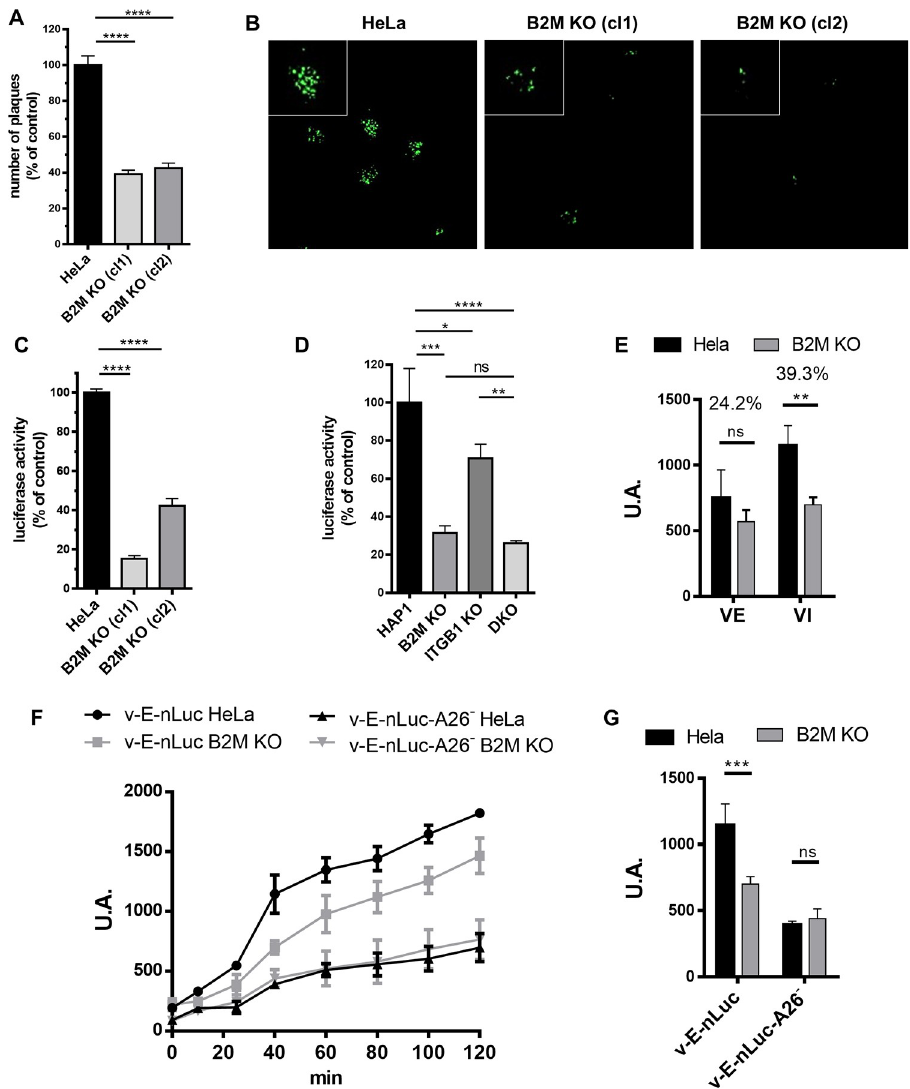
Fig 6. Effect of B2M inactivation on the early steps of Vaccinia virus infection. A) MW6 well plaques with HeLa and B2M KO clones 1 and 2 were infected with 200 pfu/well of V-GFP. Plaques were counted at 24 h.p.i B) Images of representative plaques under the microscope by GFP fluorescence. C) and D) Early luciferase expression was taken as a measure of virus entry. HeLa (C) and HAP1 (D) cells were infected with V-e.Luc at m.o.i. = 0.8 and luciferase activity was measured 3 h.p.i. Error bars indicate SD of three independent experiments. E) Infection of B2M deficient cells with extracellular virus (EV) and intracellular virus (IV). F) Time course expression of A26-defficient VV in B2M KO cells. nLuc expression was measured in triplicates in the culture medium of cells infected with the indicated viruses. G) Effect of A26 deletion on virus entry. nLuc activity at 40 min after virus adsorption is shown. p-values: ���� < 0.0001, ��� < 0.001, �� < 0.01, � < 0.05, ns >